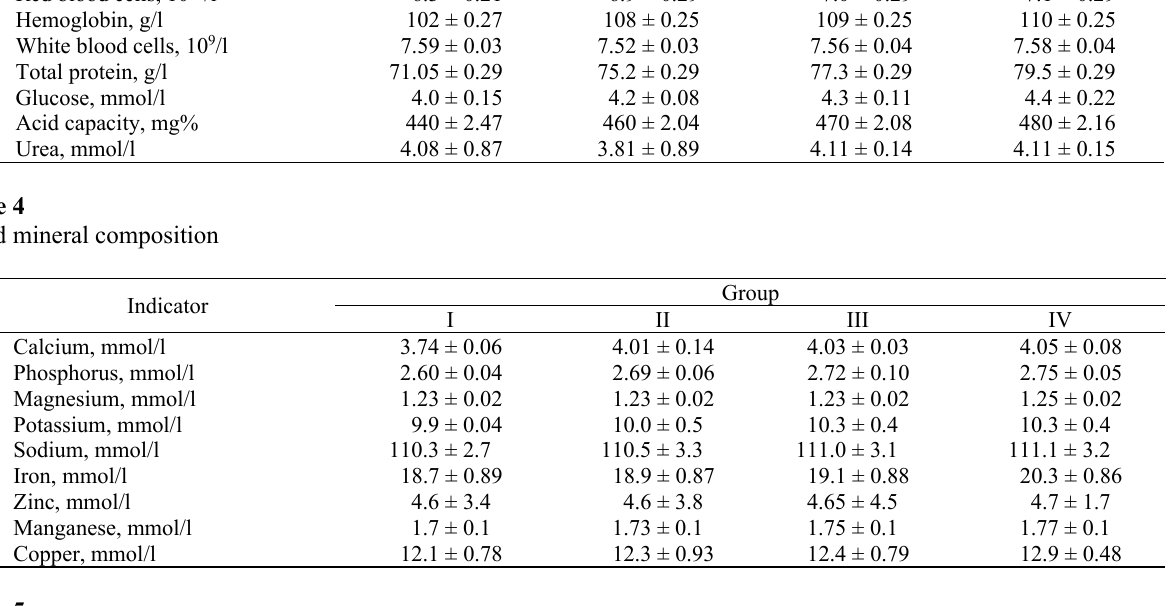
Morpho-biochemical composition of blood Indicator